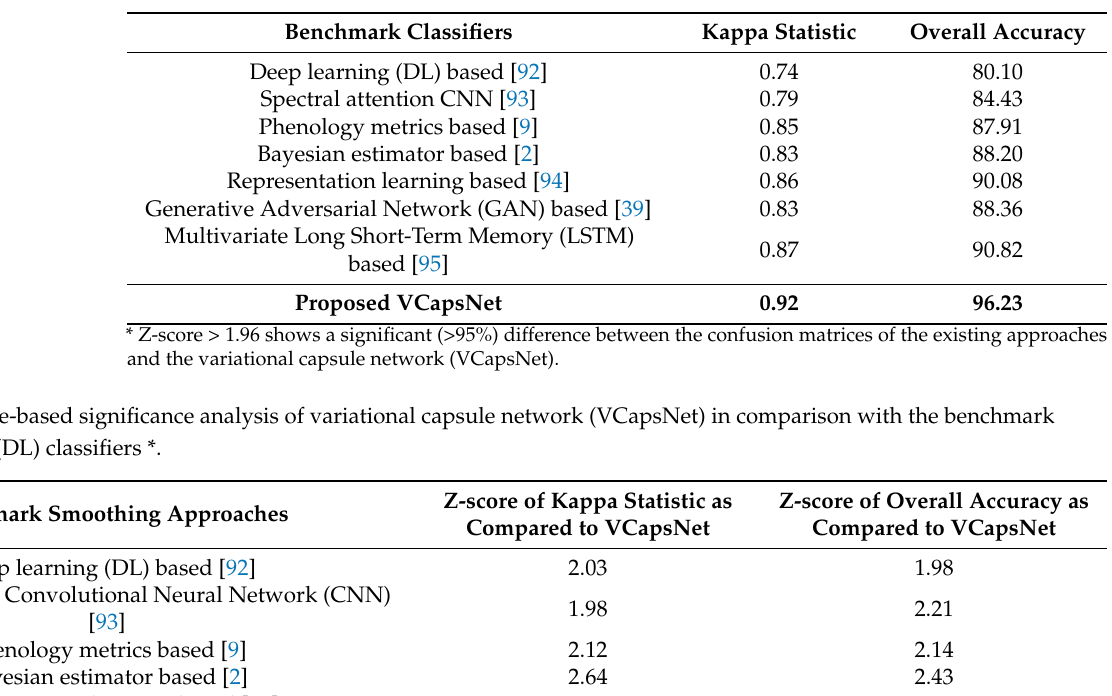
Table 2. Comparison of the variational capsule network (VCapsNet) with benchmark deep learning (DL) classifiers for 40% of training samples *.